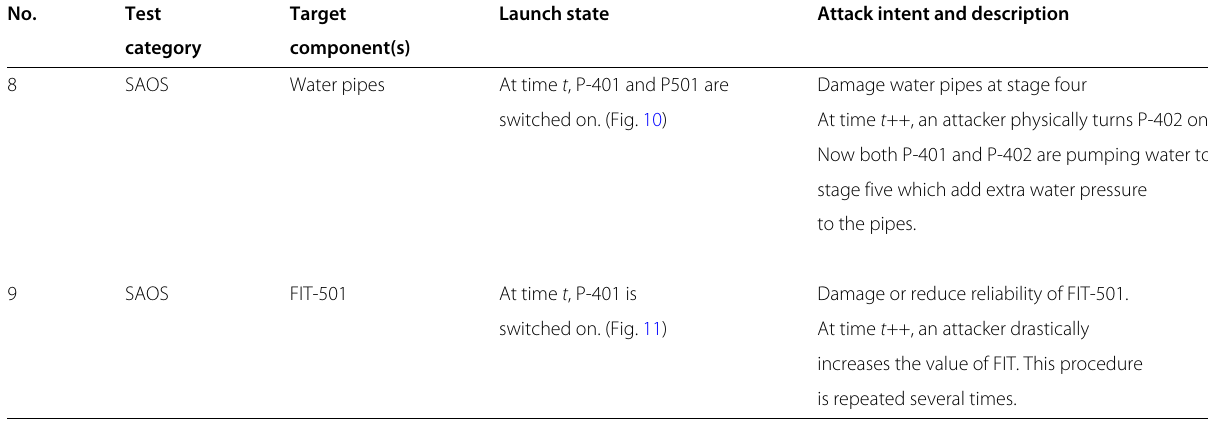
Table 11 Attacks launched on SWaT to test our invariant checkers ( Continued )